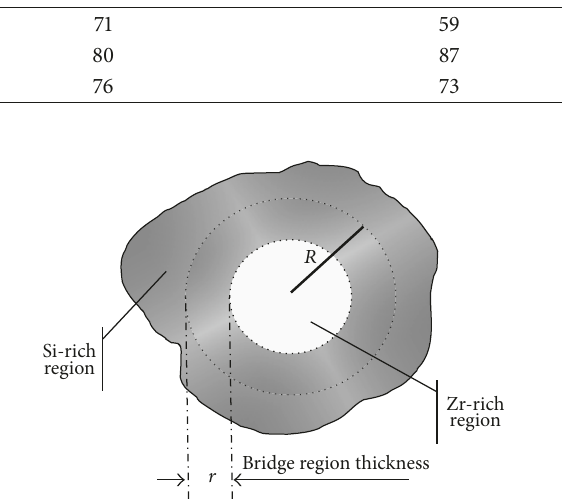
Figure 5: Schematic representation of metamict state as proposed by the authors.